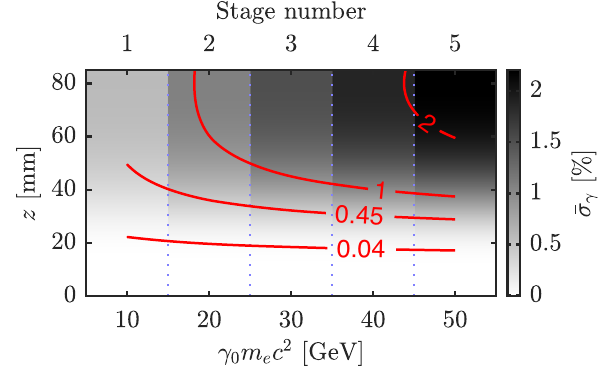
FIG. 12. Relative increase in energy spread per stage due to ICS with the drive laser when accelerating in the 3rd plasma period. The λ ¼ 1 μ m laser is assumed to be externally guided in each ¼ 70 μ m and a ¼ 1 . 5 . Contours of 1% and 2% stage with σ 0 x relative energy spread increase per stage are marked alongside the required values (0.45% and 0.04%) to achieve a final energy spread of 1% and 0.1% at 50